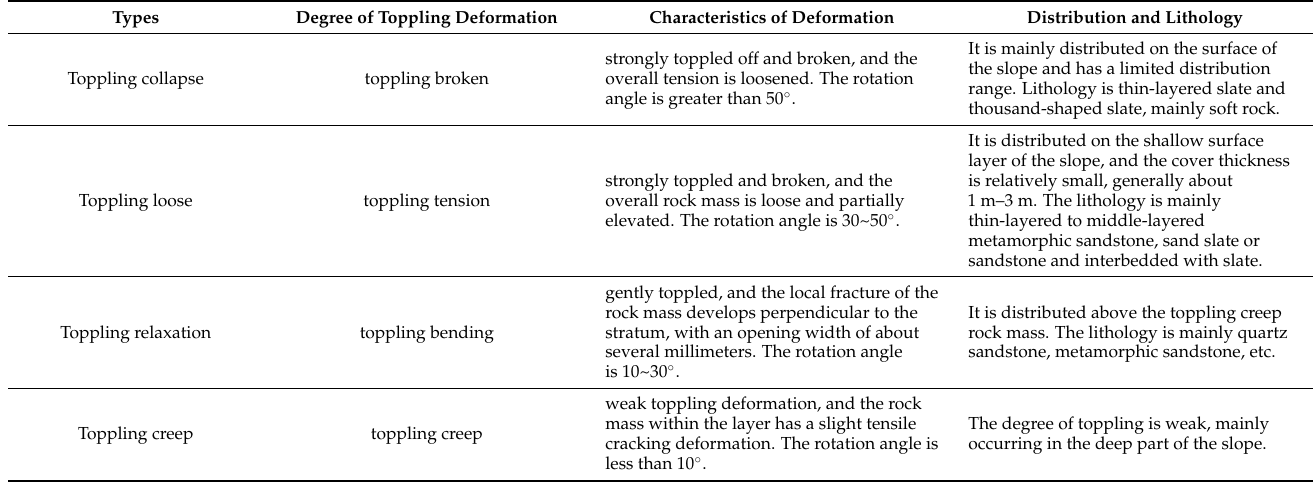
Table 4. Types of toppling deformation rock masses in the reservoir